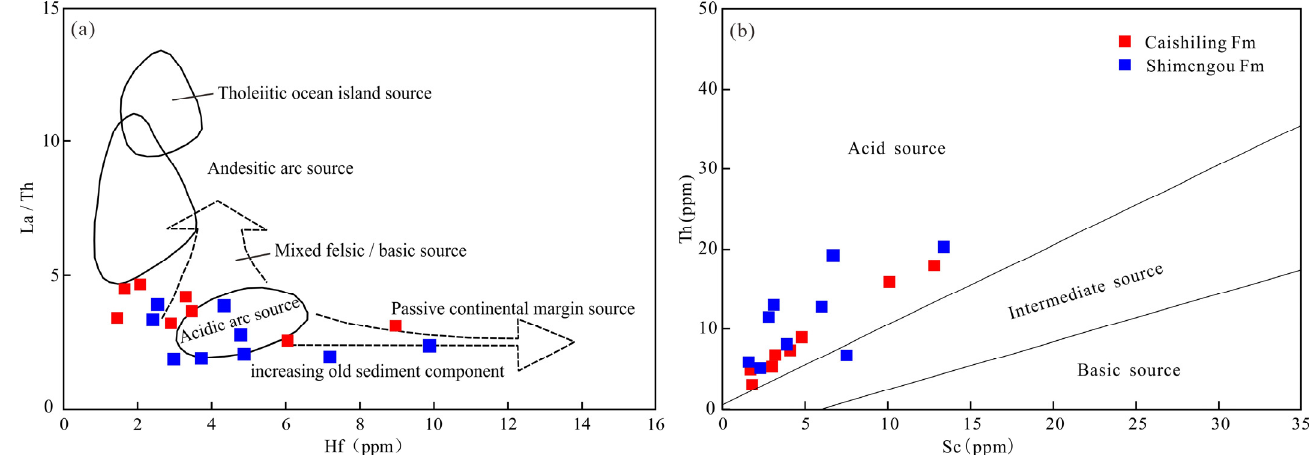
Figure 8. Provenance discrimination diagrams of ( a ) La/Th–Hf and ( b ) Th–Sc for sandstones in the studied area (modified after [38,39]).